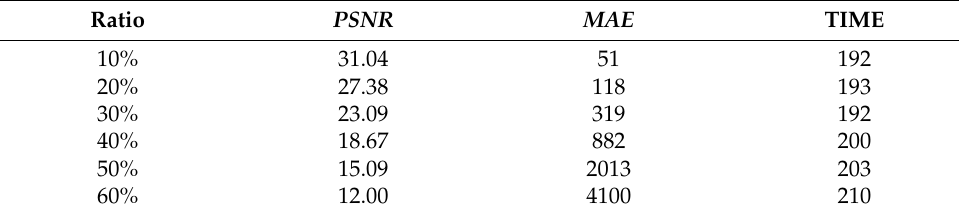
Table 4. The TASOM results for different Impulsive Noise Densities.